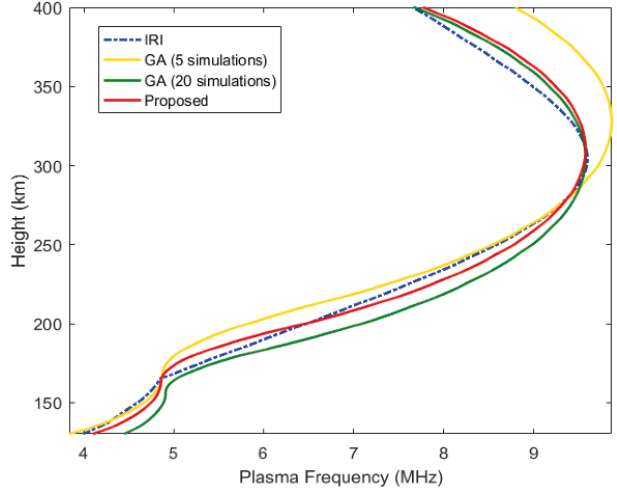
Figure 4. Comparison of electron density profile inversion results.